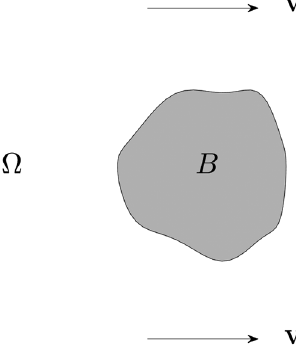
FIG. 3. Flow around a finite body B in an unbounded region Ω filled with fluid moving at a velocity V at far